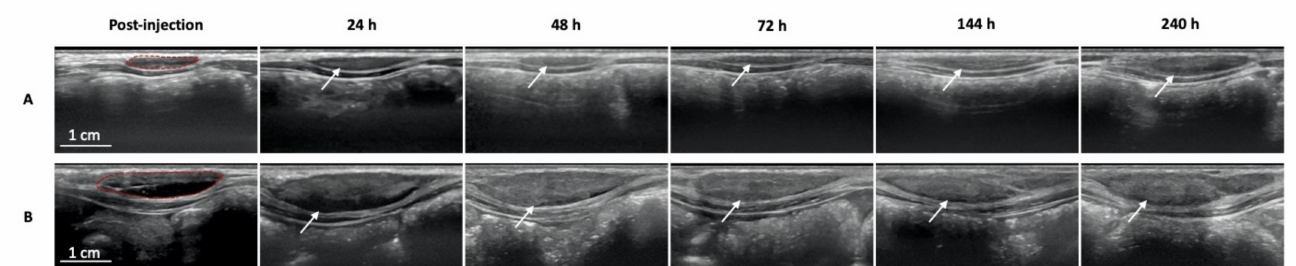
Figure 2. Longitudinal ultrasound imaging of ( A ) 0.2 mL and ( B ) 1 mL test item injection site over the course of the study. Images were acquired between 13 and 15 MHz along the sagittal plane, parallel to the needle insertion orientation. Bolus are highlighted in red post-injection and indicated by an arrow at later time